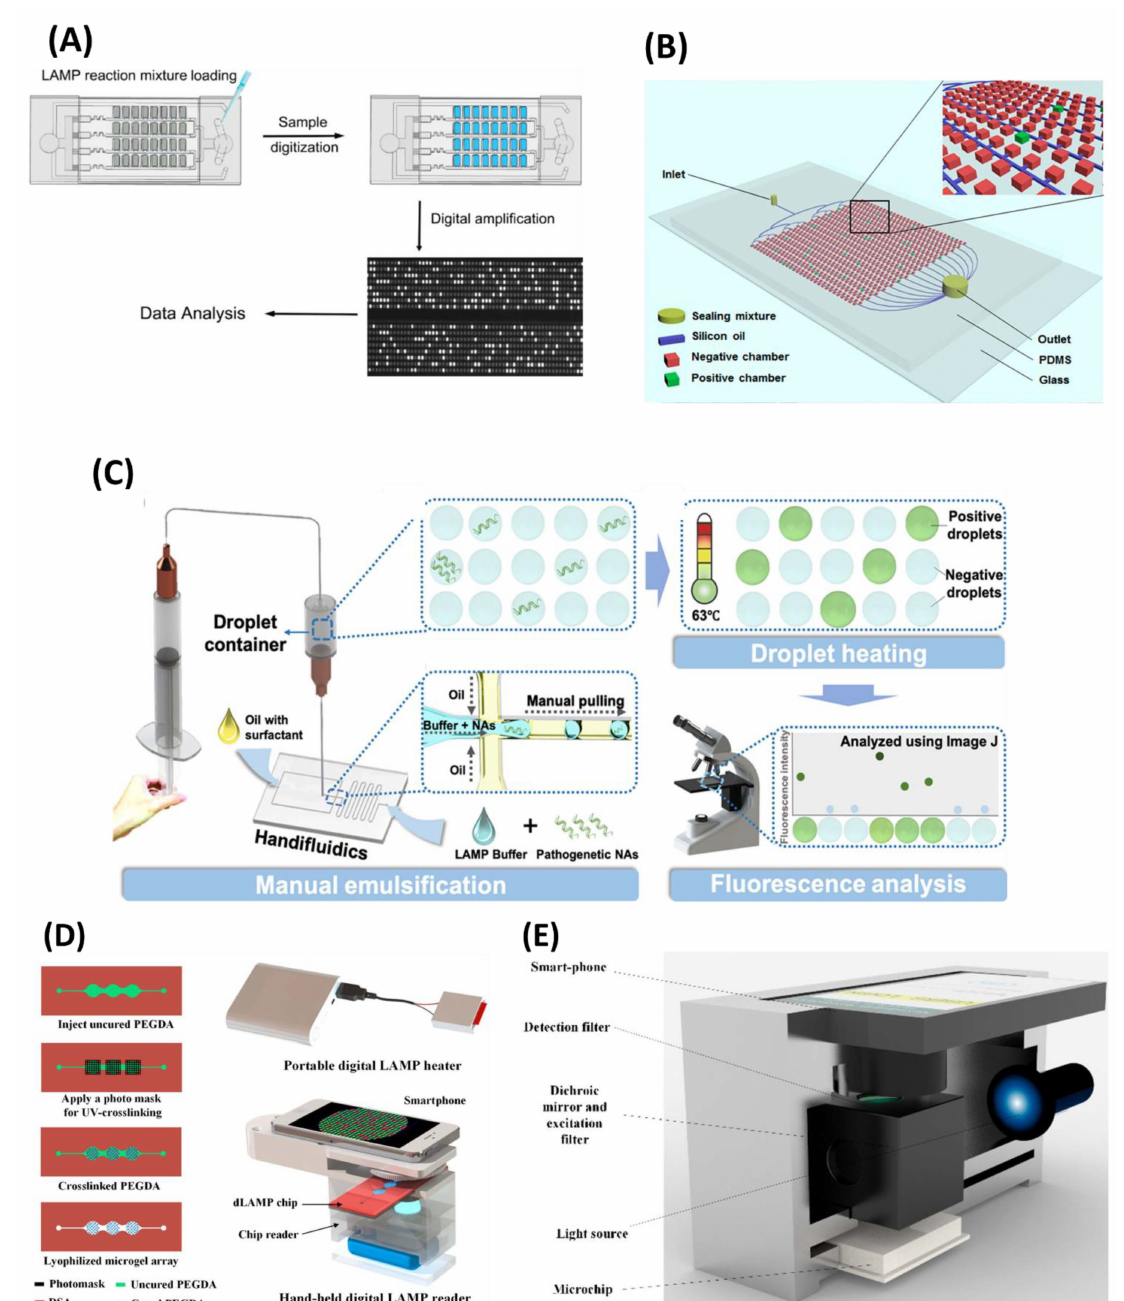
Figure 8. Schematic illustration of digital LAMP methods for detection of LAMP